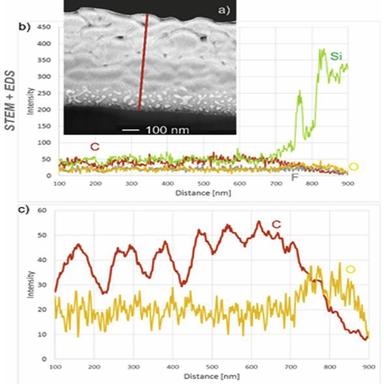
Qualitative chemical analysis (EDS) of the PTFE + SiO2/silicone multilayer coating on the PEEK substrate performed along the line perpendicular to the coating-substrate interface: a). STEM image of the coating on the marked line for EDS analysis; b). diagram of the selected elemental distribution along the line; and c). diagram of the carbon and oxygen distribution along the line.